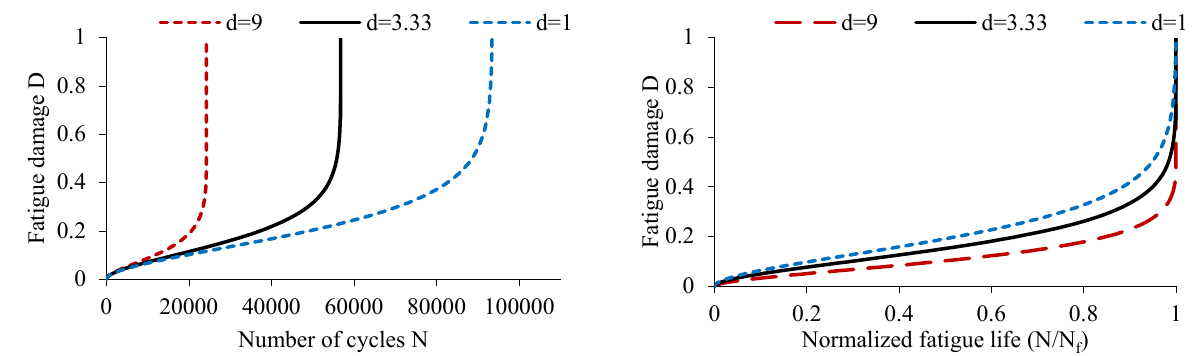
Figure 10. In fl uence of parameter “d” on the damage evolution. Figure 10. Influence of parameter “d” on the damage evolution.